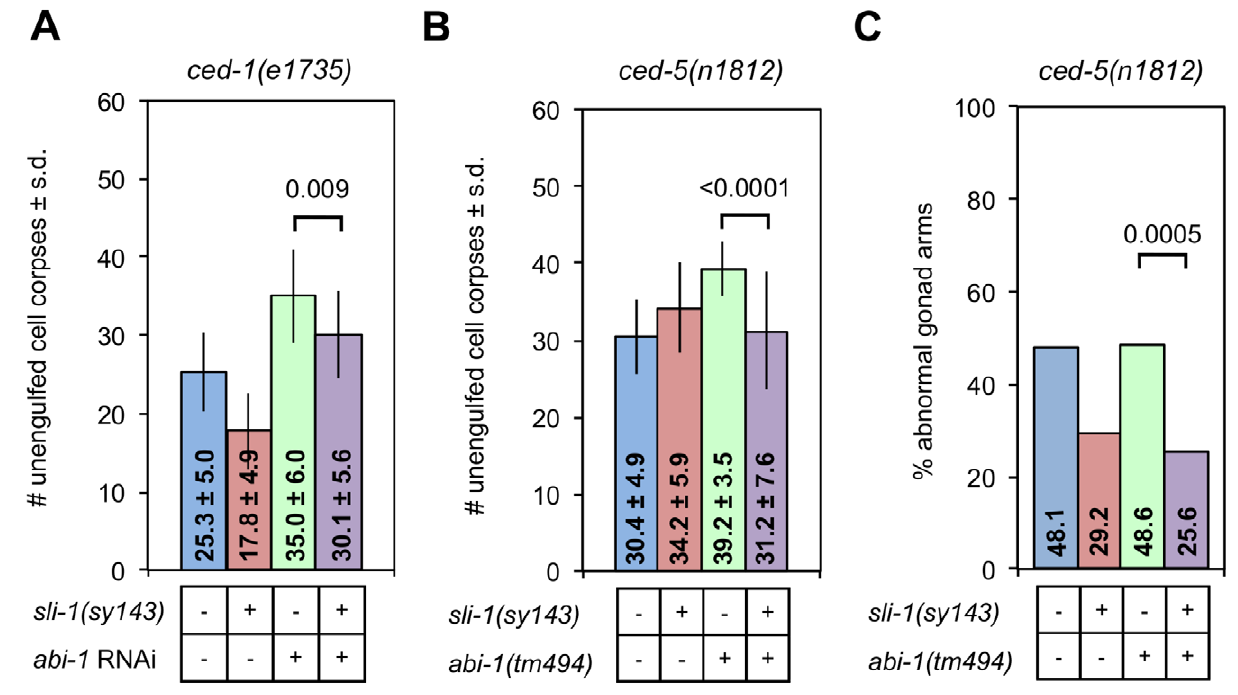
Figure 6. Loss of sli-1 function suppresses engulfment and DTC migration defects in an abi-1 loss-of-function mutant. (A) The heads of ced-1(e1735) L1 animals with or without the sli-1(sy143) mutation and with or without treatment with abi-1 feeding RNAi were scored for engulfment defects using DIC microscopy. The mean 6 standard deviation (s.d.) is indicated within each bar. Error bars are sd. p values derived using Student’s t test are shown. At least 15 animals were analyzed for each genotype. (B) The heads of ced-5(n1812) L1 animals with or without the sli-1(sy143) and/or abi-1(tm494) mutations were scored as in (A). At least 15 animals were analyzed for each genotype. (C) The gonads of ced-5(n1812) young adult worms with and without mutations in sli-1(sy143) and/or abi-1(tm494) were scored for morphology using DIC microscopy. More than 80 gonad arms were scored for all genotypes. p values derived using Fisher’s exact test are shown.